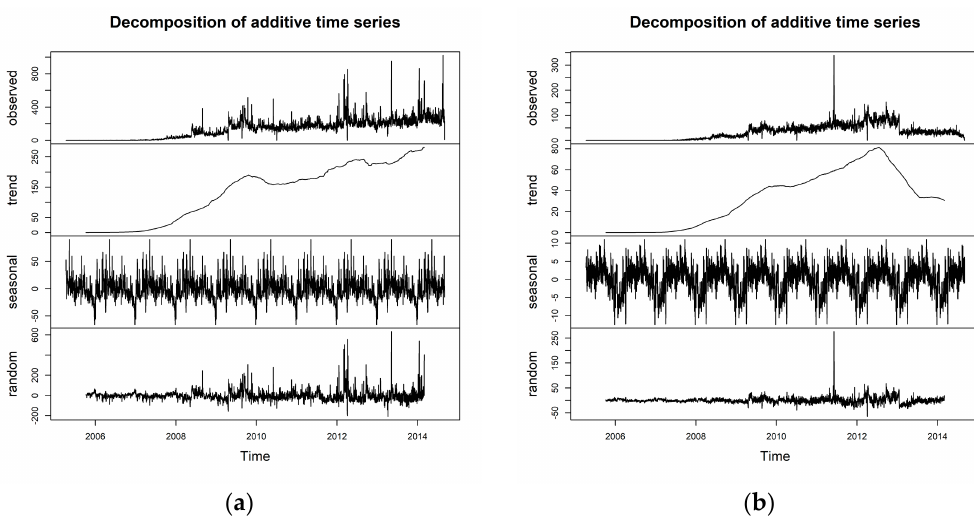
Figure 5. Compared time series analysis plots for participants who contributed more than once where ( a ) shows the time series for new contributors and ( b ) shows the time series for withdrawn contributors with seasonal and random components adjusted for the peak event. Both graphs show the observed values, trend, seasonal, and random components that indicate the estimated number of contributors.